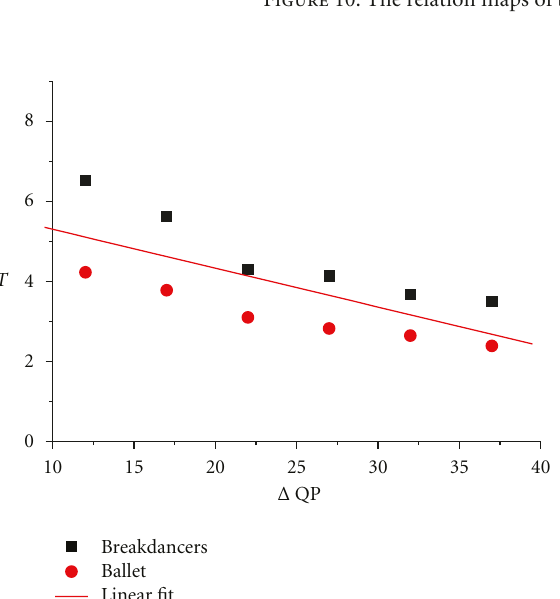
Figure 10: The relation maps of bit saving ratio R BSR ( b QP,0, Δ QP) to Δ QP.